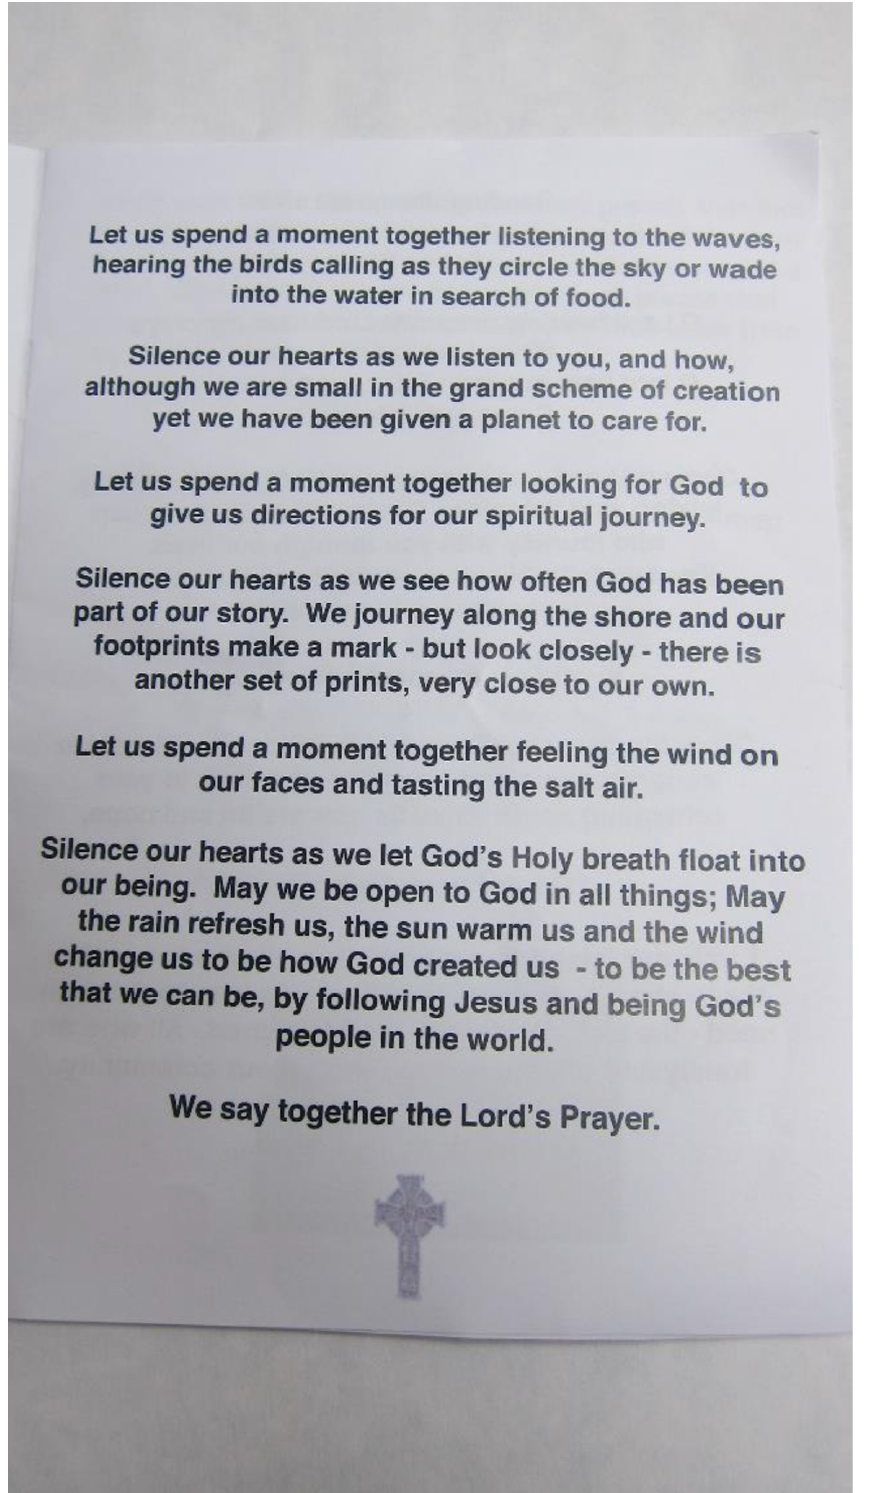
Figure 3. Praying the Keeills service sheet, Niarbyl 2011, cover and page 3 (courtesy of Praying the Keeills).